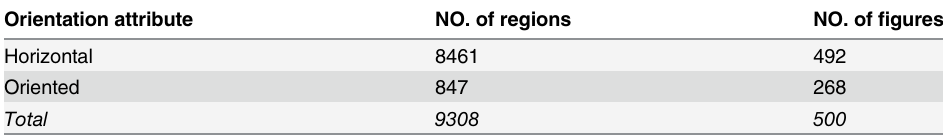
Table 4. Statistics of text (word) regions with orientation attributes.